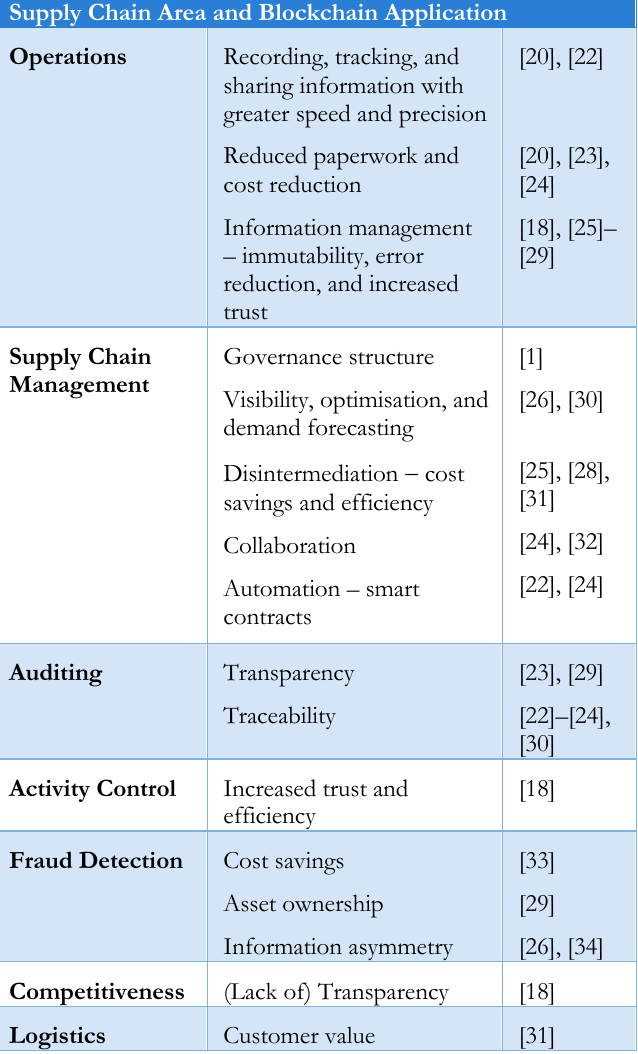
Table 1. Supply Chain Area and Blockchain